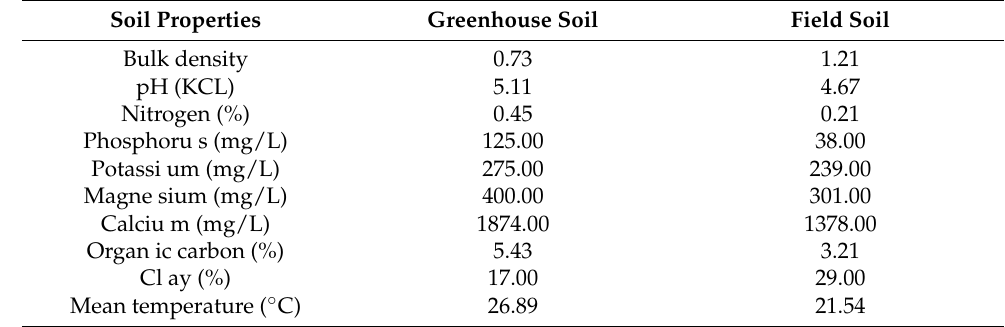
Table 2. Soil properties and mean temperatures for two study sites.